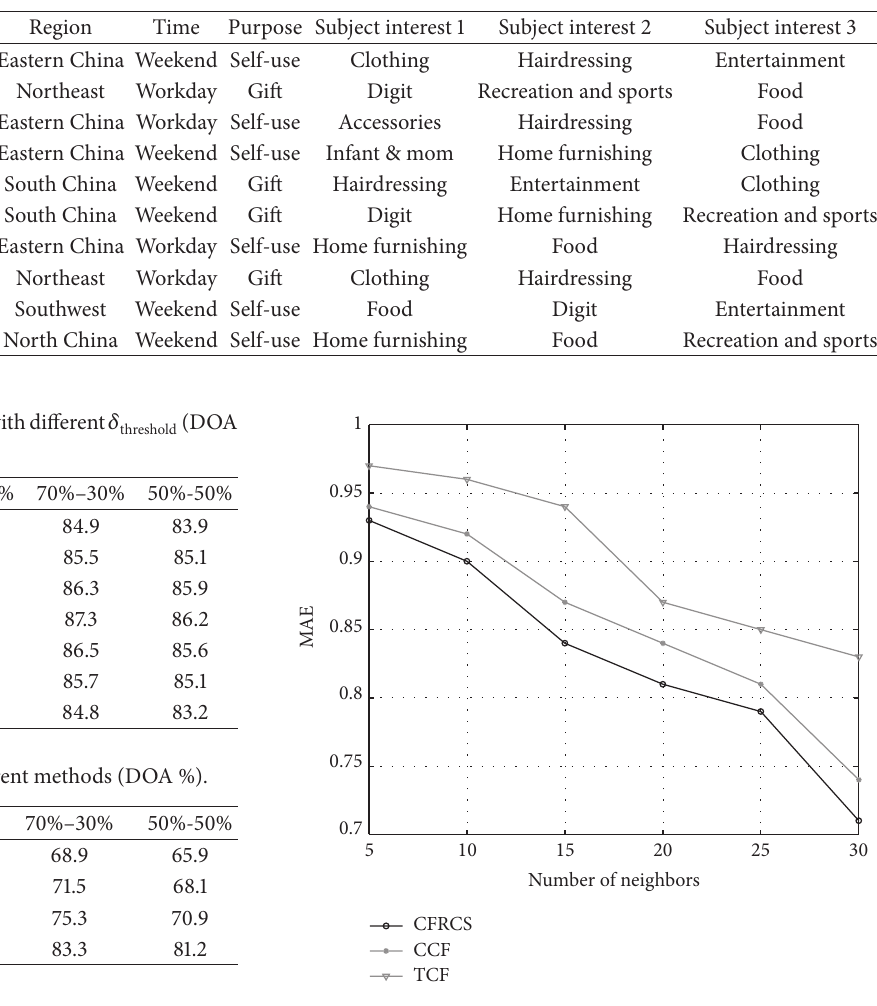
Figure 4: MAE of three algorithms in an e-commerce data